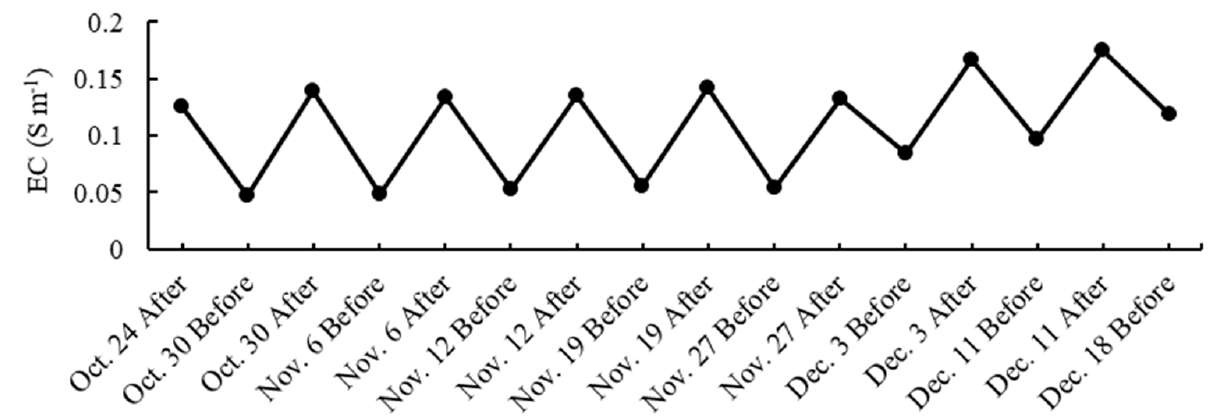
Figure 2. Changes of solution electrical conductivity (EC) before and after quantitative fertilizer application in 1 K (Control) treatment plot.